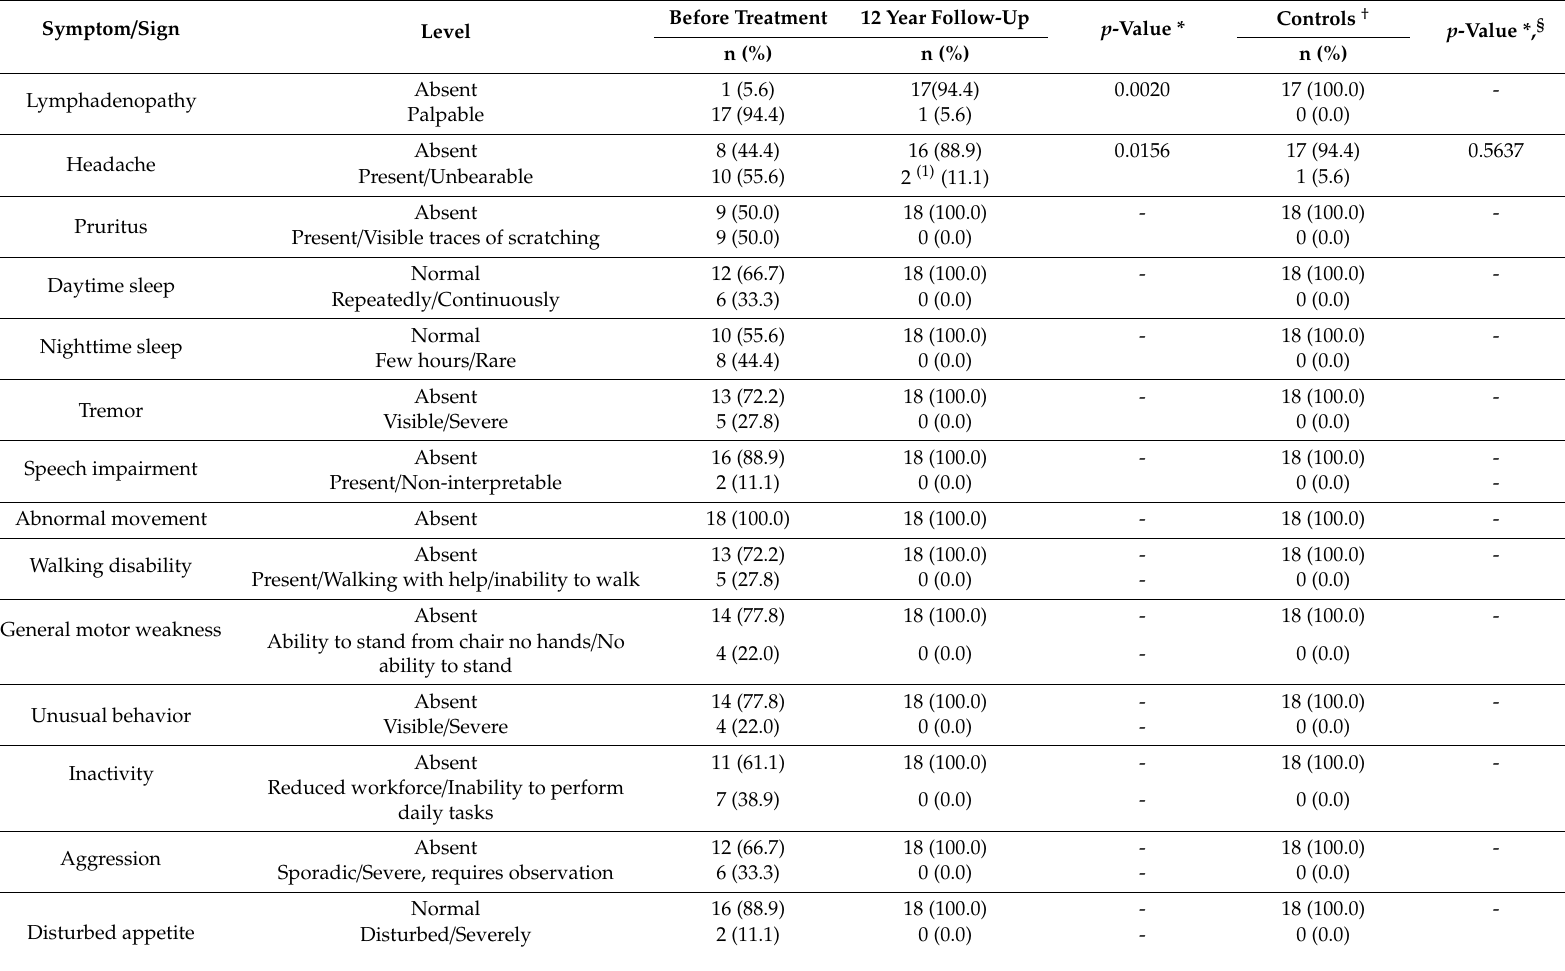
† p -Value * Controls p -Value *, §